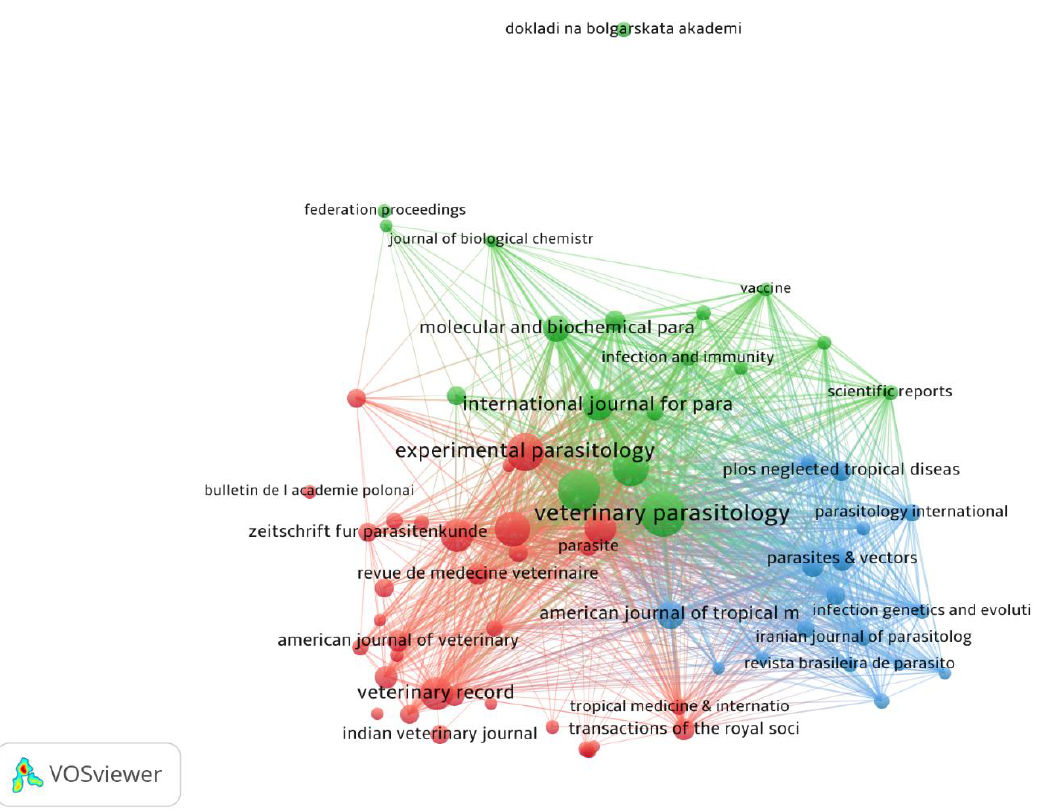
Figure 6. Network visualization of bibliographic coupling sources based on documents.